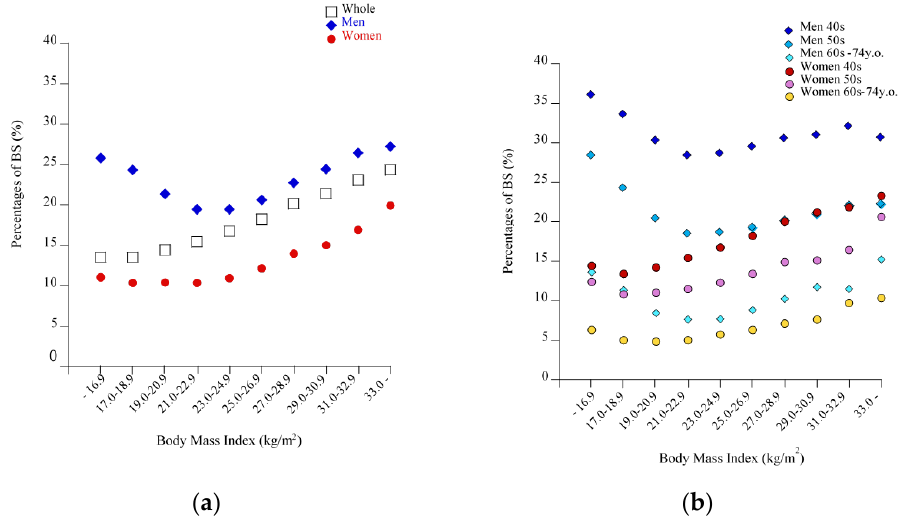
Figure 1. Percentages of breakfast skipping (BS) according to BMI categories, sex, and three age groups. ( a ) All subjects, men, and women. ( b ) Men in their 40s, 50s, and 60–74 years old, and women in their 40s, 50s, and 60–74 years old. Each symbol indicates the percentage for that group.